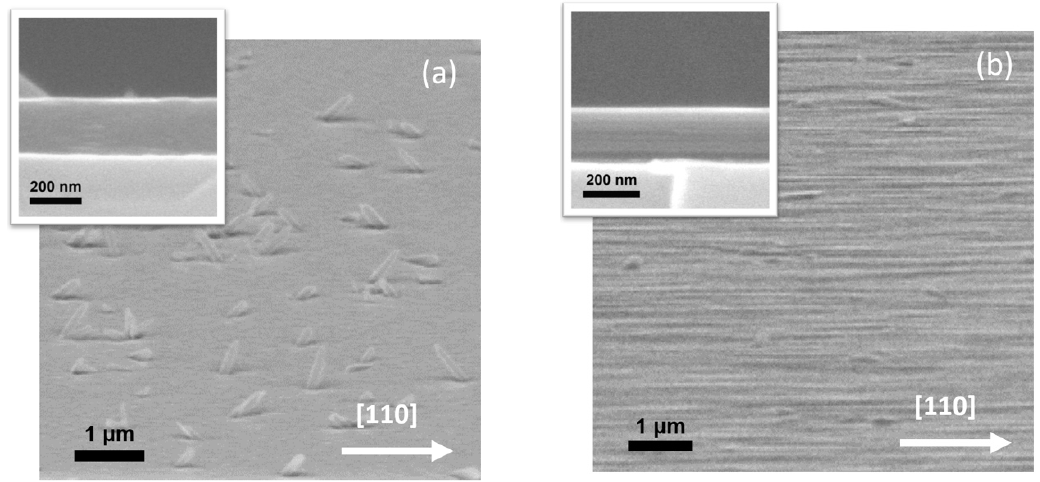
Figure 15. Plan-view SEM images of the GaTe layers grown on GaAs(001) substrates at different substrate temperature: ( a ) sample # GT1 , T S ≈ 450 °C; ( b ) sample # GT2 , T S ≈ 530 °C. The insets show the cross-section SEM images of corresponding structures.